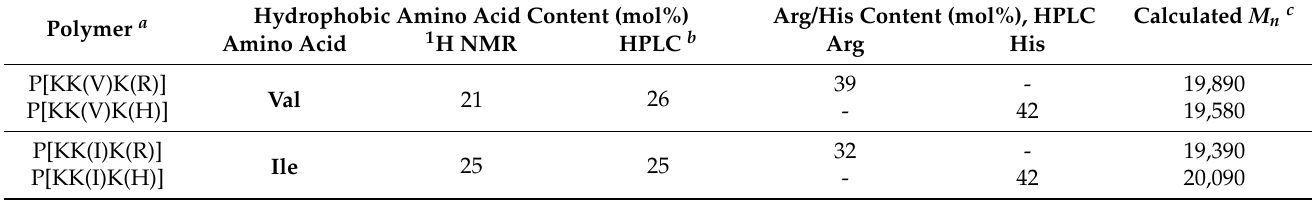
Table 2. Composition of the amphiphilic copolymers obtained by the post-polymerization modifica- tion of poly- L -lysine with various hydrophobic and basic amino acids. Polymer